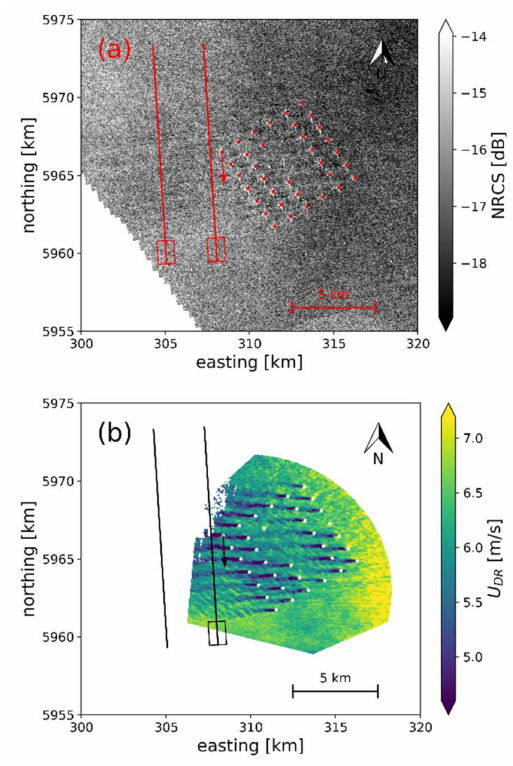
Figure 8. Case 2 (09-04-2018 at 17:04 UTC): ( a ) SAR backscatter image and ( b ) Doppler radar wind speed at 100 m.